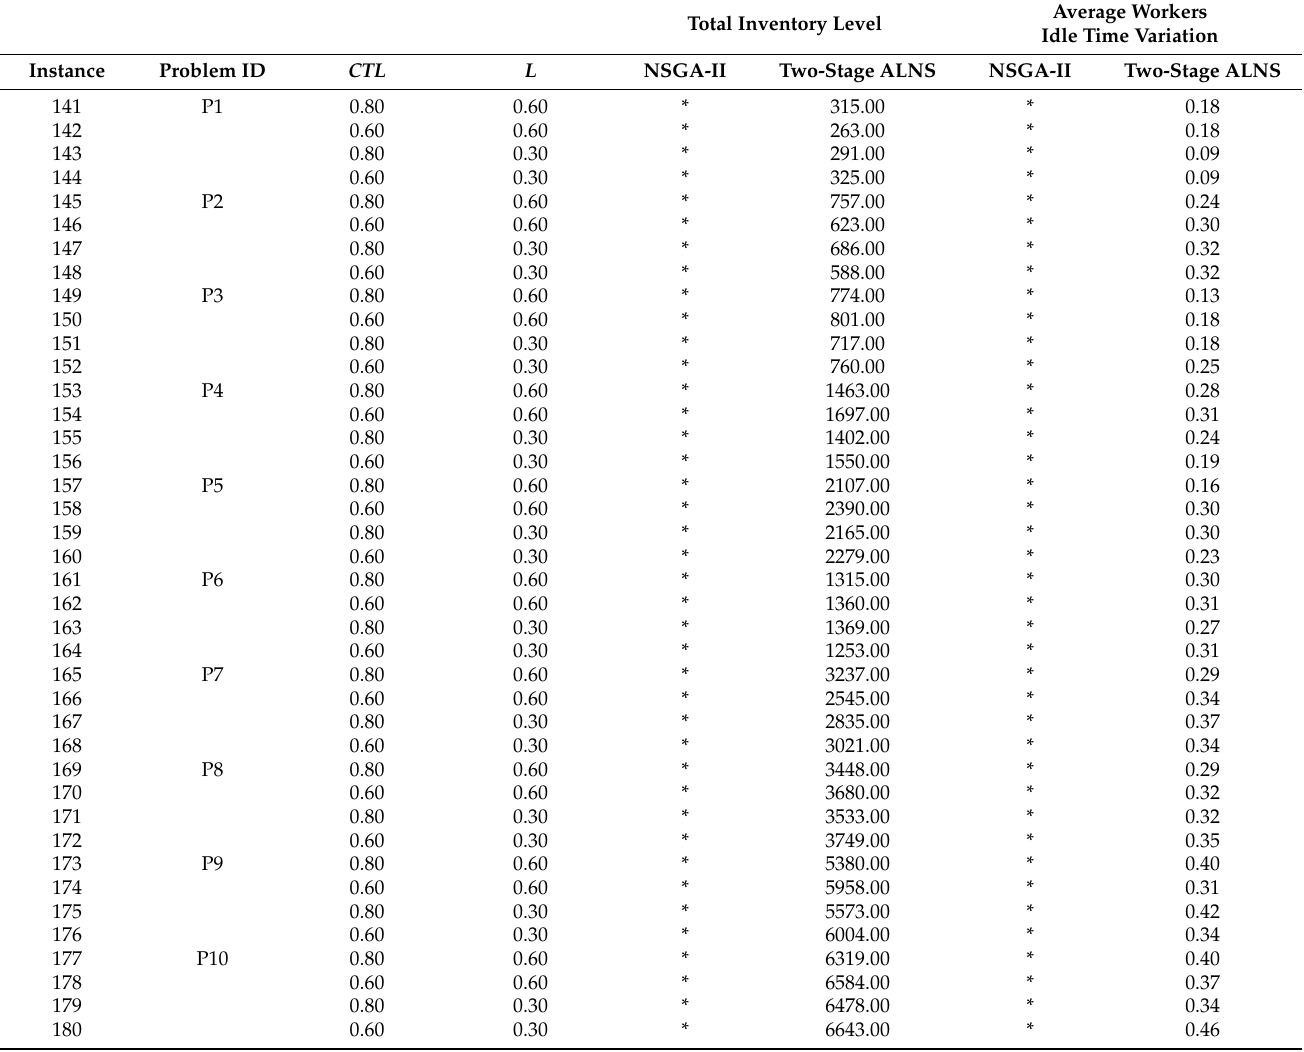
Table 17. Results of instances obtained using the NSGA-II and two-stage ALNS methods. Total Inventory